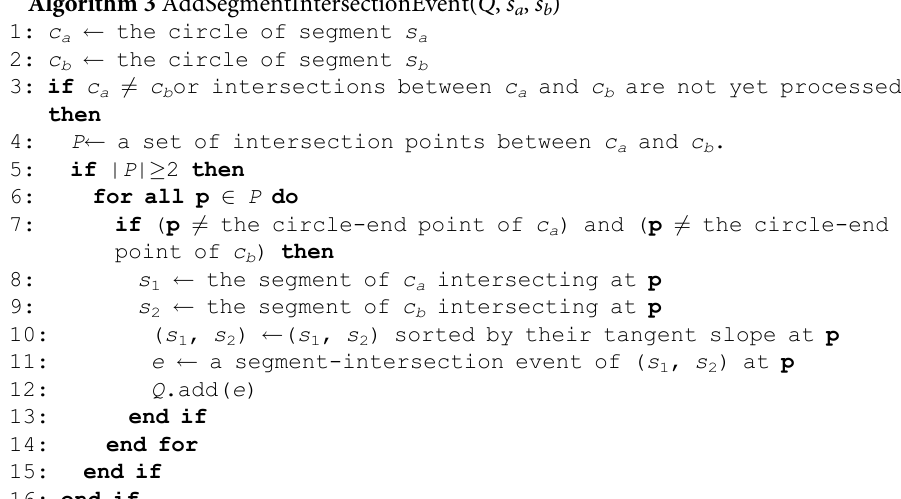
Algorithm 3 AddSegmentIntersectionEvent( Q , s